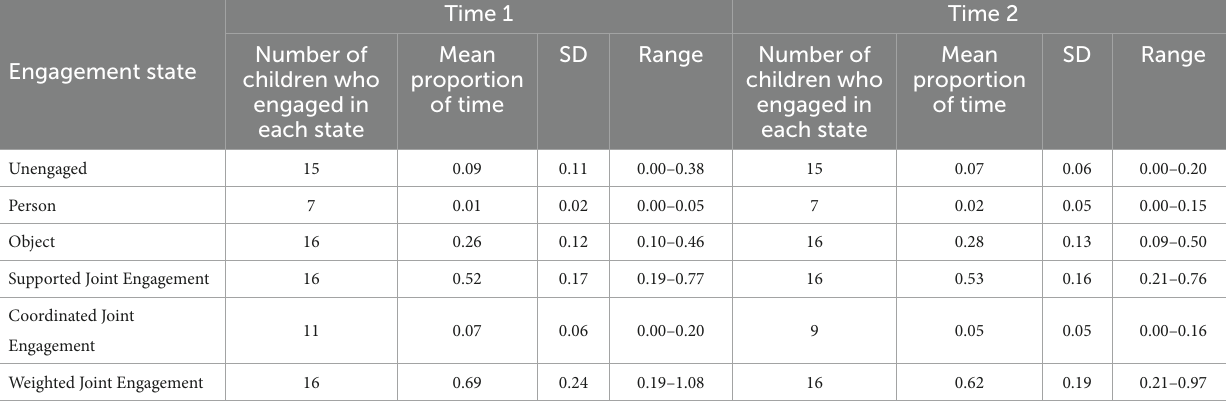
TABLE 3 Frequency and mean proportion of time spent in each engagement